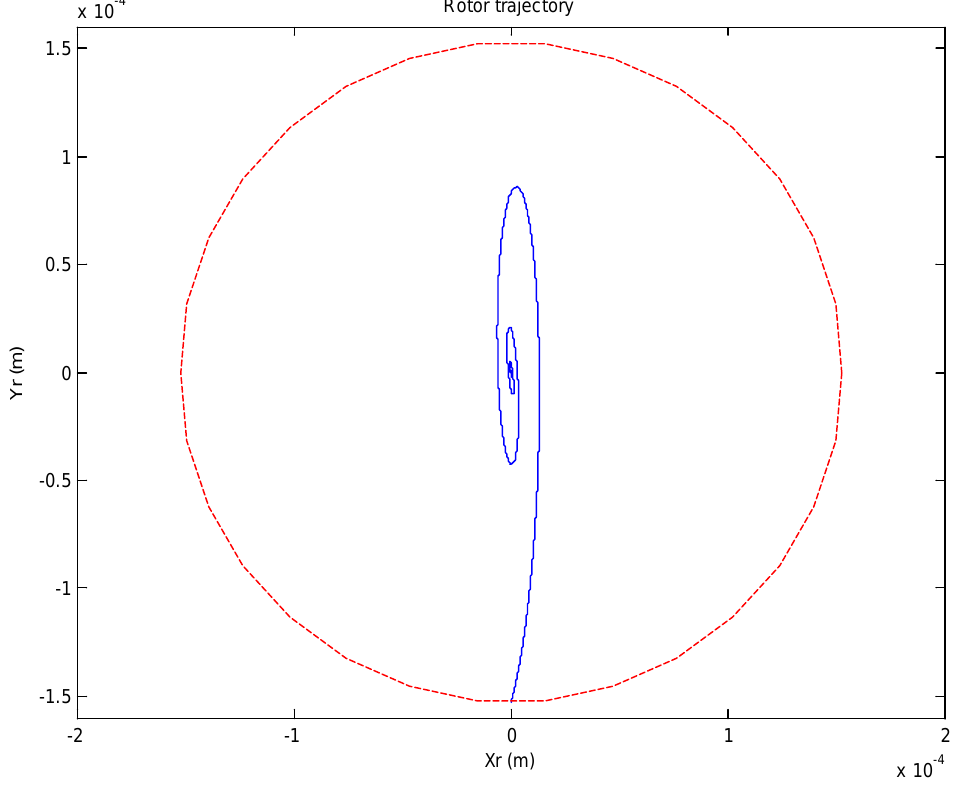
Figure 4. Simulation result: rotor trajectory.